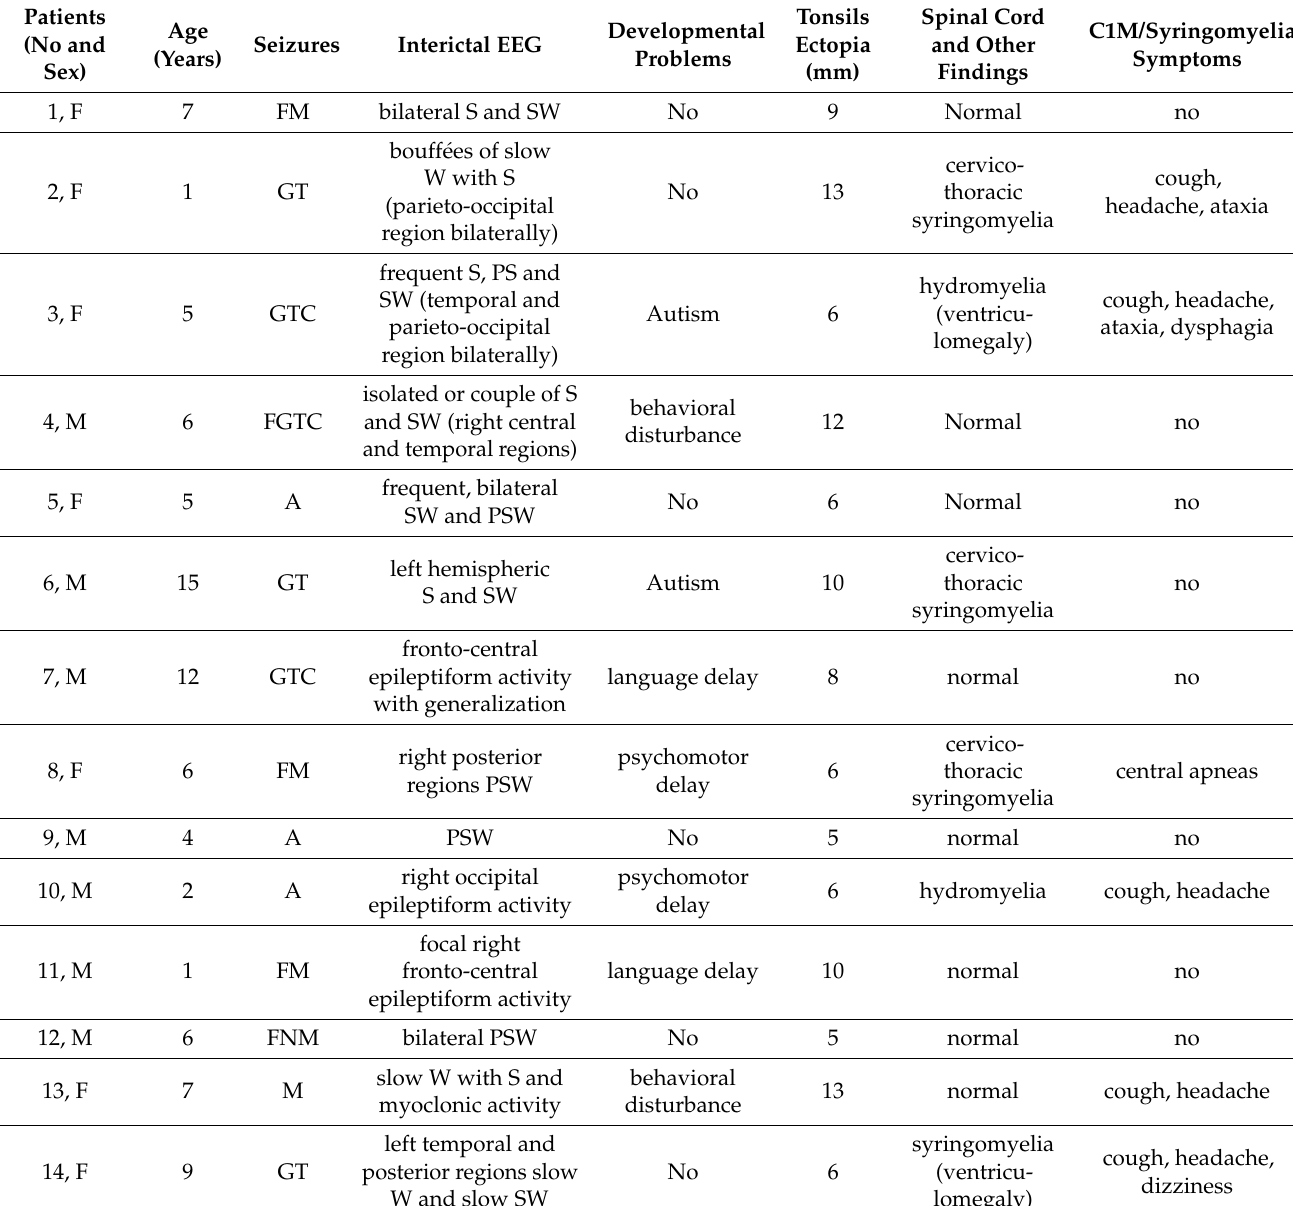
Figure 2. 3T MRI of the same case in Figure 1. On sagittal view, C1M is evident, with moderate hypoplasia of PF and 8 mm ectopia of cerebellar tonsils ( A , arrow). No relevant findings are visible on sagittal view after gadolinium administration ( B ) or on T2 axial views ( C , D ). Table 1. Clinical characteristics of Group 1.